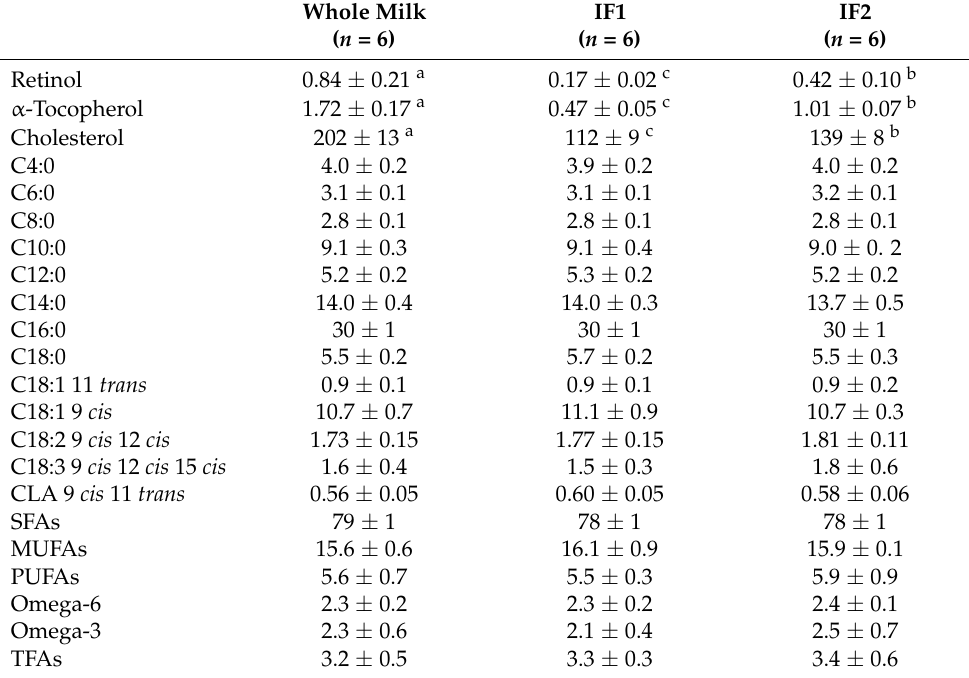
CLA 9 cis 11 trans , conjugated linoleic acid—rumenic acid; SFAs, saturated fatty acids; MUFAs, monounsaturated fatty acids; PUFAs, polyunsaturated fatty acids; TFAs, trans fatty acids. Different letters in a row indicate mean differences statistically significant at p <